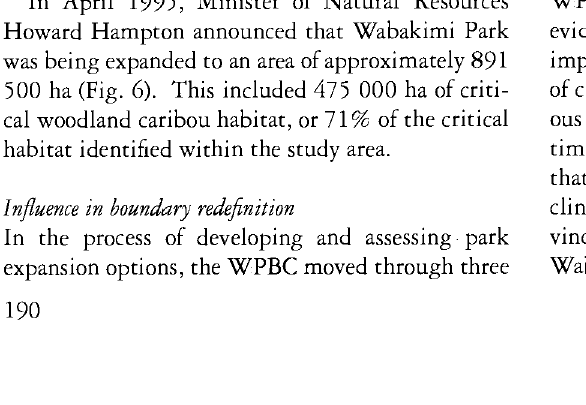
existing park. The 577 100 ha Concept K